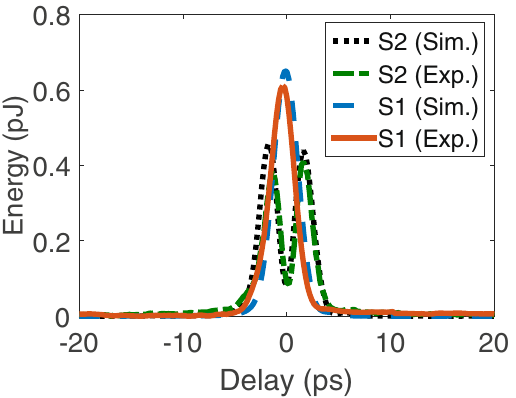
Figure 9. Selective conversion versus signal-pump delay. Measured and simulated SF power for the second example described in Section 2.3, where the signals correspond to the first two modes of a Gaussian TF filter, and the pump is optimized to selectively convert Signal 1 with a 2-ps pulse